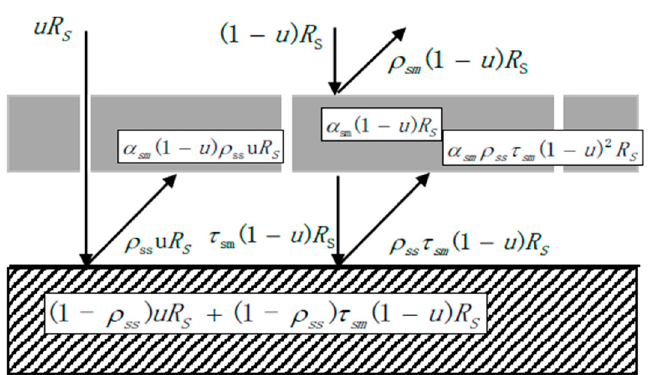
Figure 2. Schematic diagram of energy transport with perforated plastic film mulch.